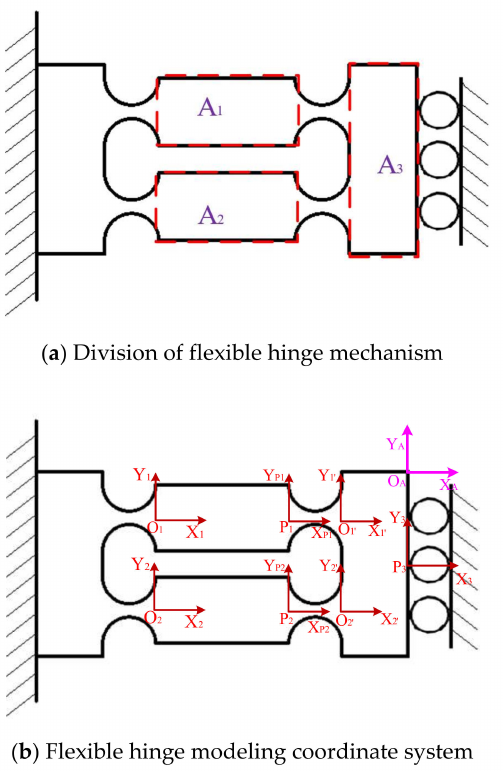
Figure 3. MCM model of driving flexible